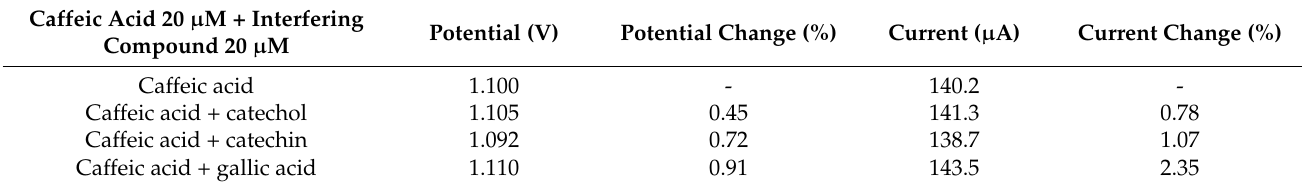
Table 3. Interference study results on the response of biosensor SPCE/PB/HRP immersed in 20 µ M of caffeic acid.